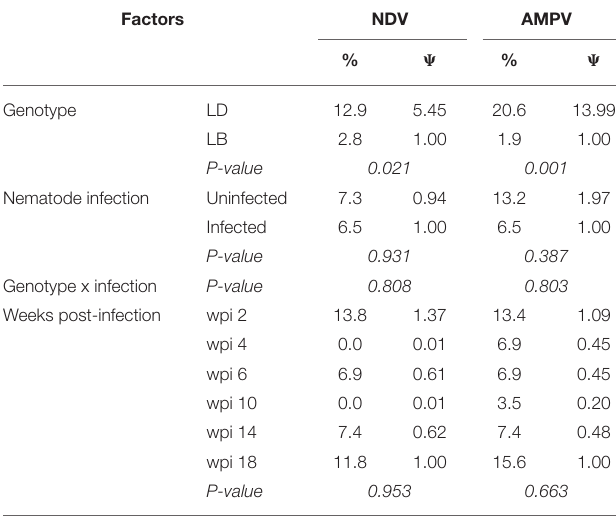
TABLE 4 | Frequency (%) and odds ratios ( 9 ) assessing the probability of being weak-responder to vaccination against Newcastle Disease Virus (NDV), and Avian Metapneumovirus (AMVP) in relation to host genotype, nematode infection, and weeks post-infection (wpi) in laying